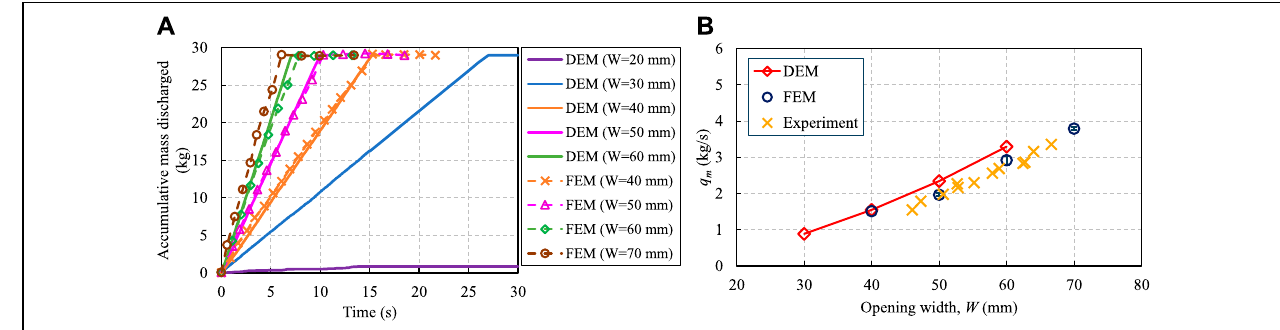
FIGURE 2 | Quantitative comparison of (A) the cumulative mass discharged where the case with W = 20 mm is clogged, and (B) the mass flow rate q m against hopper opening width W among the DEM and FEM model predictions, and the experimental measurements, where the error bar in FEM results represents the numerical variation caused by different time step